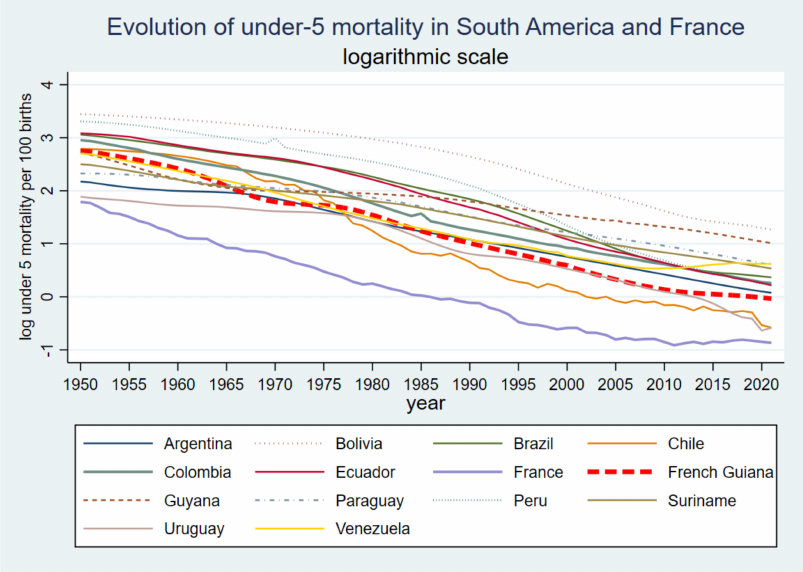
Figure 2. Evolution of under-5 mortality in South America and France (log10 scale).